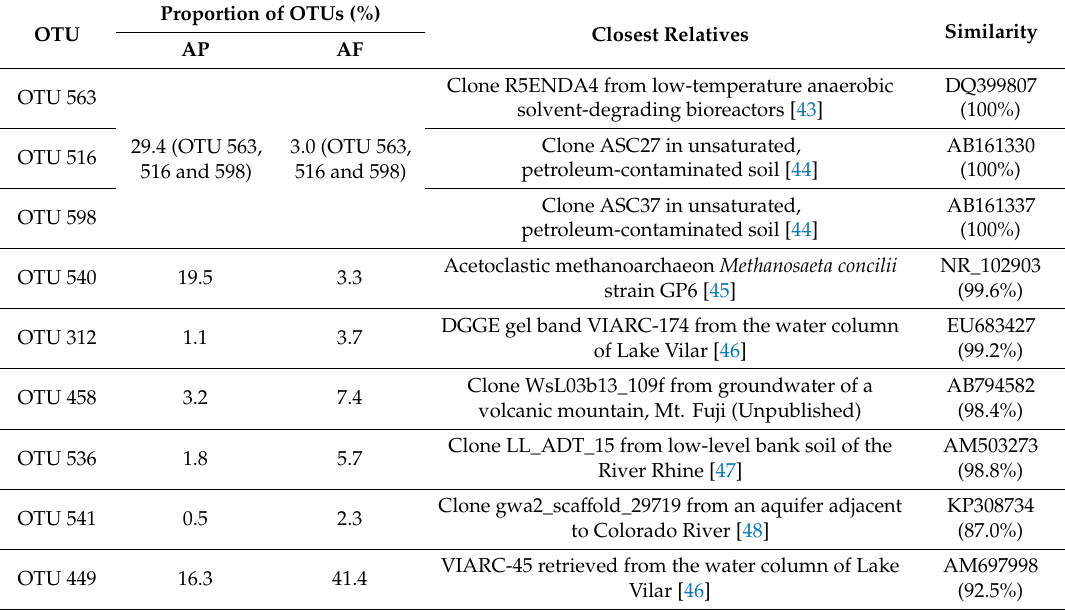
Table 4. Closest relatives of main OTUs in archaeal